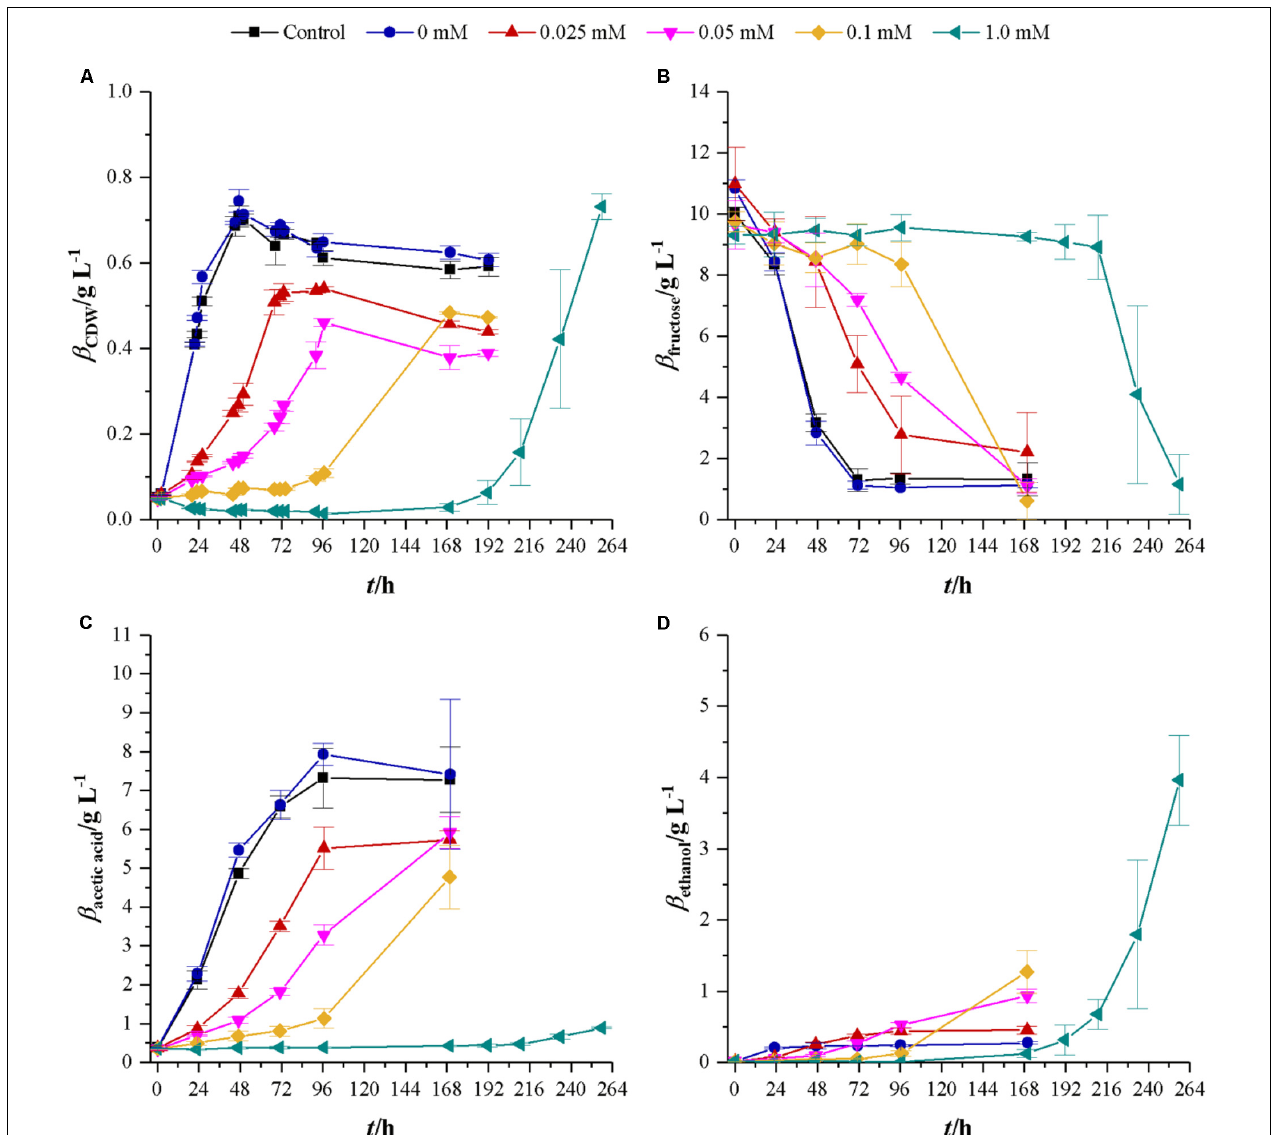
FIGURE 2 | Response of fructose growing C. ljungdahlii to increasing concentrations of cyanide. Average values for three independent bottles per concentration. Control cultures (black squares) do not contain any phosphate buffer or cyanide while cultures with 0 mM cyanide (blue dots) contain 1 mL 100 mM potassium phosphate buffer at pH 11. Other cyanide concentrations are 0.025 (red triangles), 0.05 (magenta upturned triangles), 0.1 (yellow diamonds), and 1.0 mM (petrol tilted triangles). (A) CDW; (B) mass concentration of fructose; (C) mass concentration of acetic acid; and (D) mass concentration of ethanol. Average values of three independent